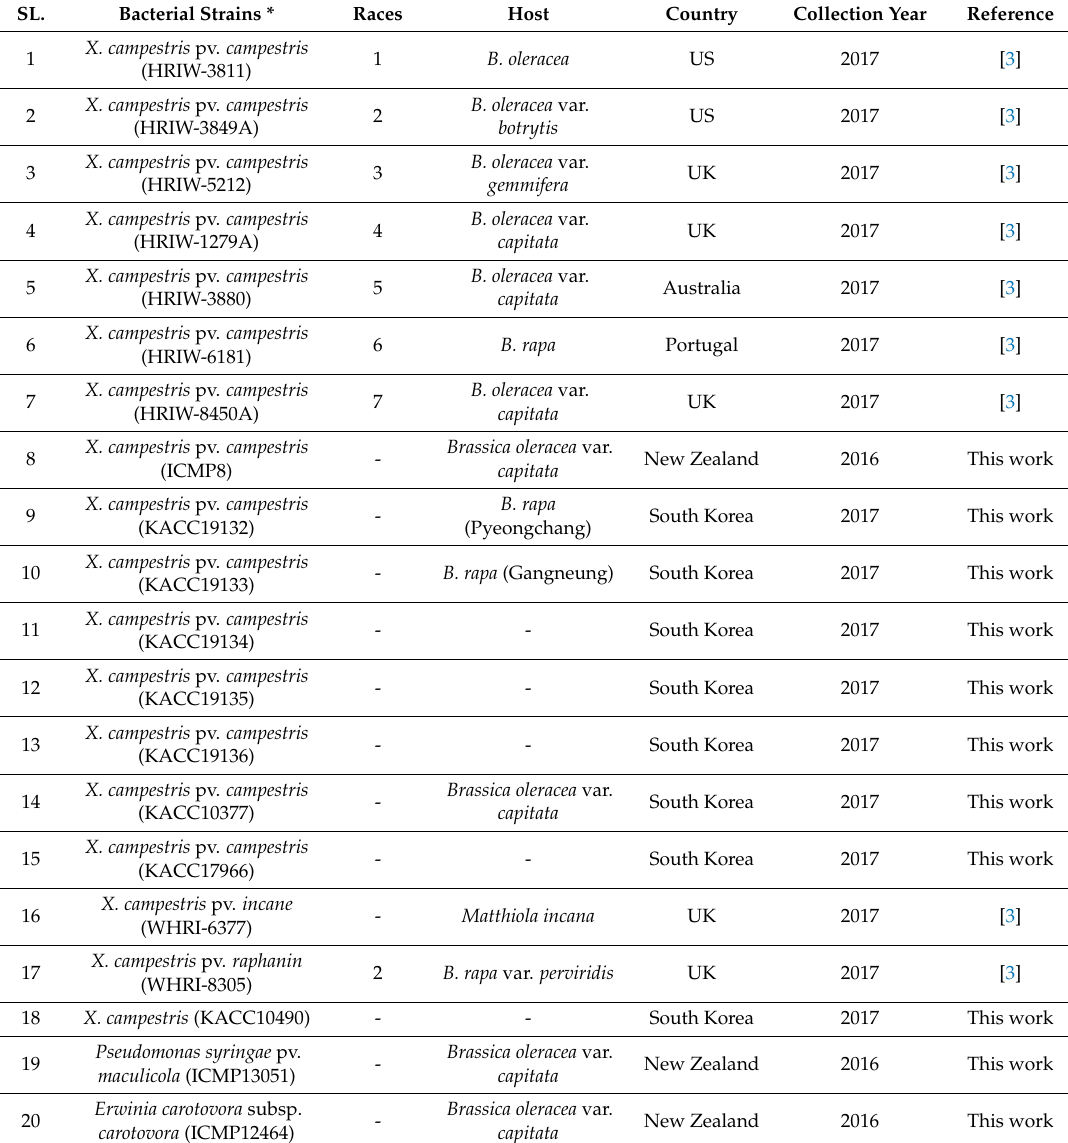
Table 2. Plant pathogenic bacterial races of Xanthomonas campestris pv. campestris , X. campestris pathovars/species and other strains used in this study with origin, host and year of collection.